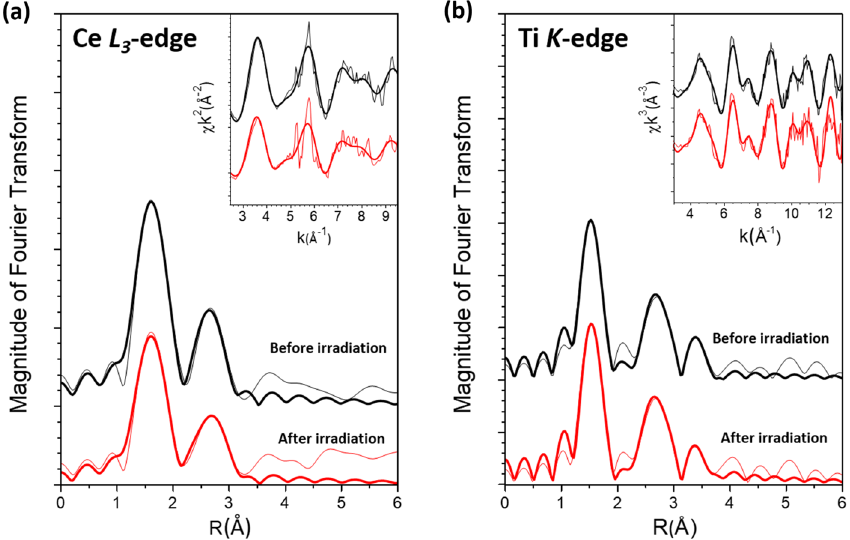
Figure 3. ( a ) Ce L 3 -edge and ( b ) Ti K-edge EXAFS data for the sample before and after 600 min of UV-light irradiation. Fine lines: experimental; Coarse lines: curve fitting. Curves have been shifted vertically for the sake of clarity